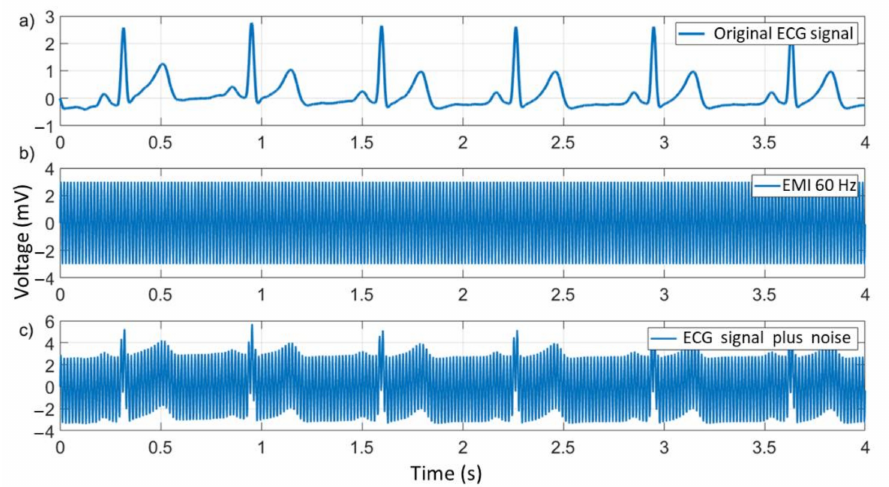
Figure 8. Original ECG signal ( a ), EMI (60 Hz) ( b ), and ECG signal plus noise ( c